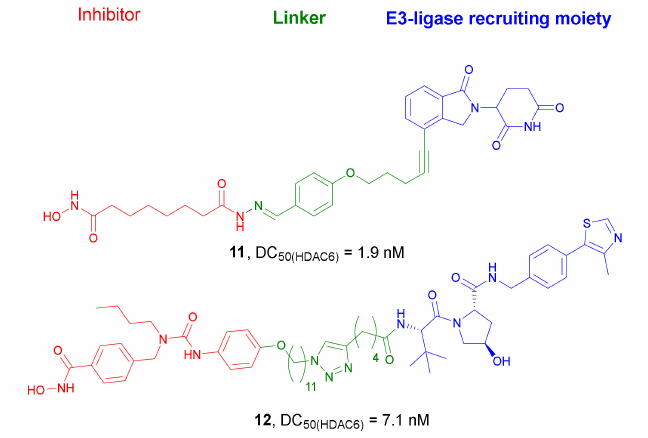
Figure 7. General structures of PROTACs 11 and 12